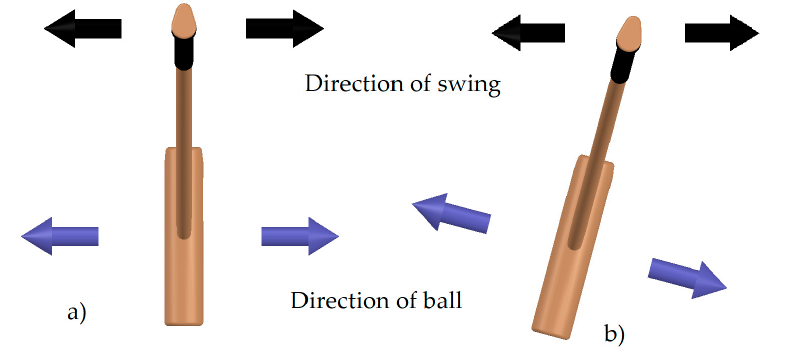
Figure 3. CAD models indicating the direction of swing of the polo mallet in relation to the angle of the head. The ball travel is ( a ) aligned to direction of swing and ( b ) aligned to the angle of the